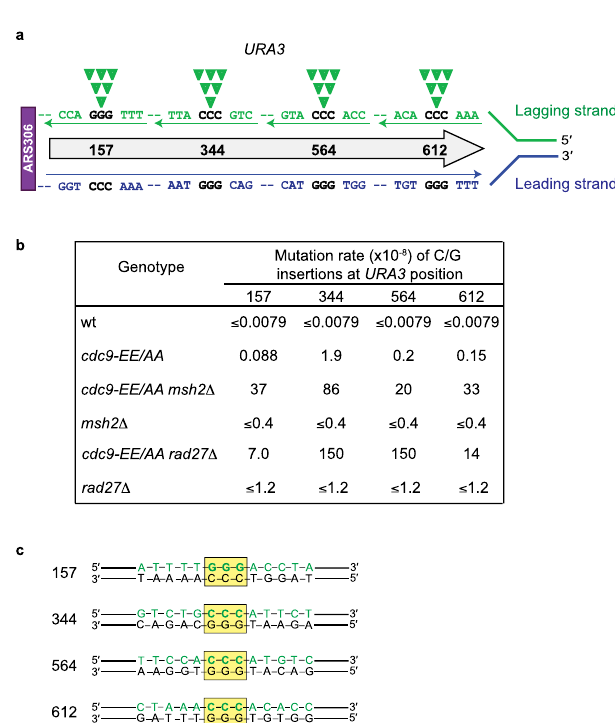
Fig. 2 Analysis of mutational hotspots for + 1 insertions in the low- fi delity cdc9-EE/AA strain + / − MSH2 or RAD27 . a A schematic of the URA3 reporter gene located adjacent to the ARS306 replication origin. Displayed is the leading strand DNA sequence synthesized by Pol ε in blue and the lagging strand synthesized by Pol δ in green. The additional C that would be incorporated by Pol δ at three of the mutation hotspots to generate a + 1 insertion is indicated by the closed green inverted triangles. b Site-speci fi c rates for + 1 G/C insertions at 4 hotspots in the URA3 reporter gene for the wt and cdc9-EE/AA strains + / − MSH2 or RAD27 . Rates were calculated as the proportion of each site-speci fi c event among the total mutants sequenced (Supplementary Table 3) multiplied by the overall mutation rate (Fig. 1c). c A depiction of the DNA sequences surrounding four of the sites in URA3 at which the mutation rate of + 1 insertions of G/C is the highest. The Pol δ -synthesized lagging strand is shown in green and the location of the homopolymer run in which an extra base would be inserted is highlighted by the yellow